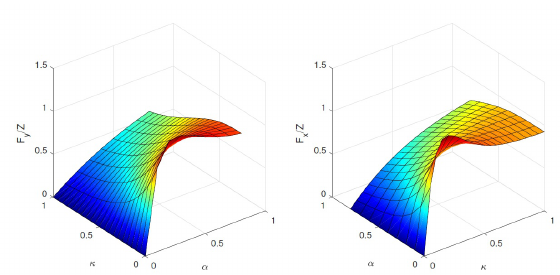
Figure 3. Tire forces given by the exponential tire model as function of slip κ and slip angles α